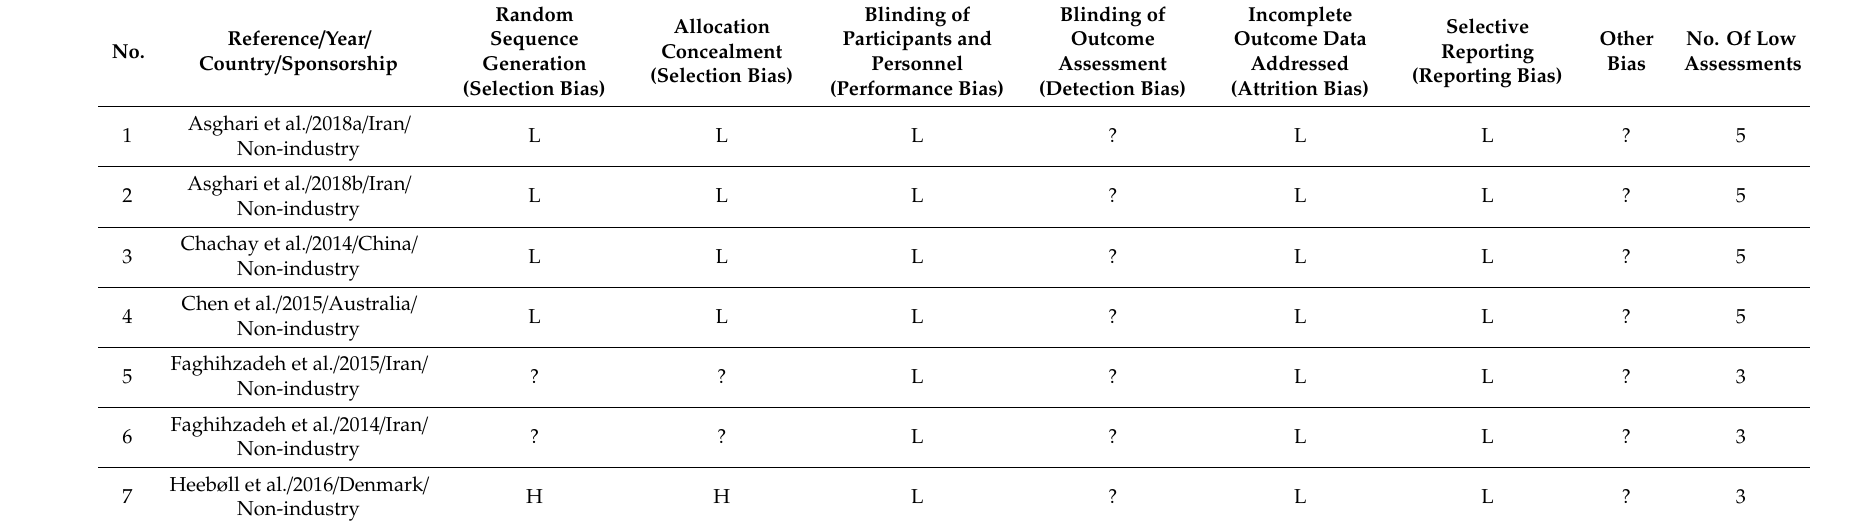
Table 2. Risk of